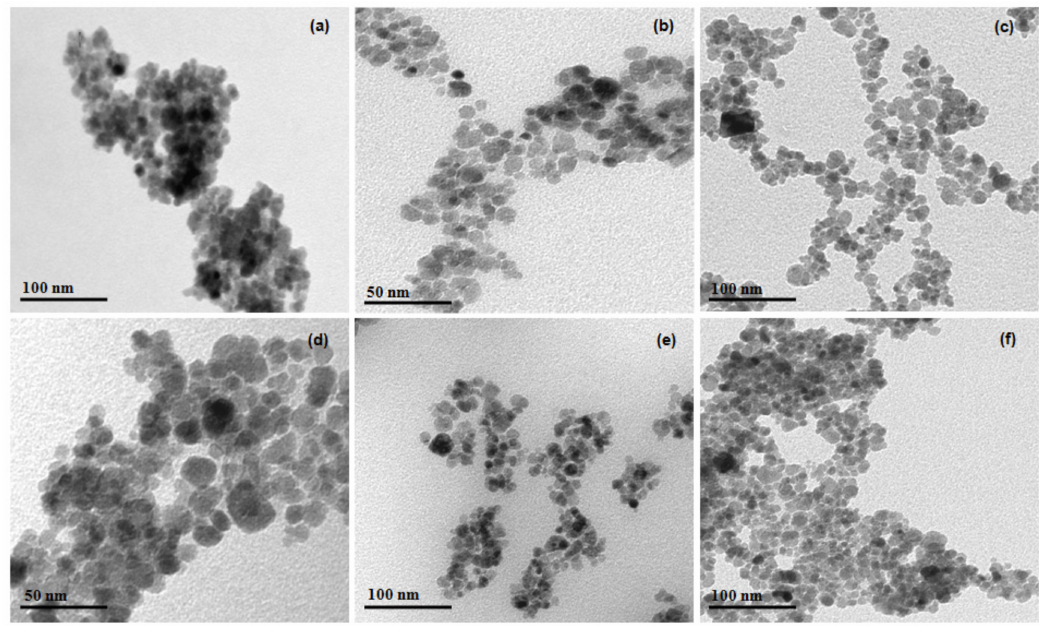
Figure 4. TEM images of ( a ) Fe 3 O 4 ; ( b ) Fe 3 O 4 @OA / Pc; ( c ) Fe 3 O 4 @OA / CuPc; ( d ) Fe 3 O 4 @OA / NiPc; ( e ) Fe 3 O 4 @OA / ZnPc; and ( f ) Fe 3 O 4 @OA /